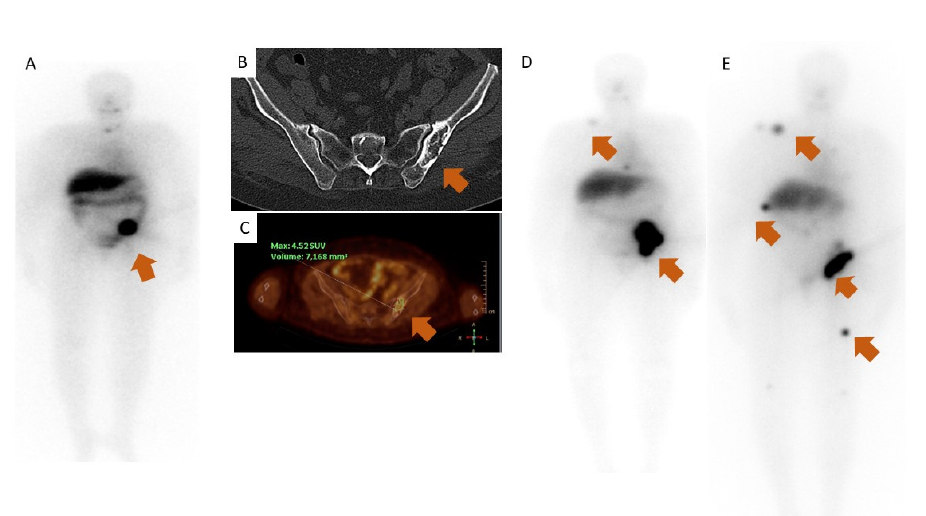
Figure 1. ( A ) Whole-body scintigraphy after 131 I treatment in 2012 showing tracer uptake (arrow) in the left iliac bone. ( B ) Computed tomography (CT) of pelvis, axial view (the arrow shows the metastasis). ( C ) 18F-fluorodeoxyglucose (18F-FDG)—positron emission tomography (PET) fused with CT. ( D ) Whole-body scintigraphy after the fourth 131 I treatment in 2018 showing an uptake in the left iliac bone and smaller areas of uptake in the right clavicle and thoracic spine (arrows). ( E ) Whole-body scintigraphy after the sixth 131 I treatment in 2020 showing an uptake in the left iliac bone and several other areas of smaller uptake (arrows). A 71-year-old woman presented in 2012 with a growing palpable mass in the right side of the neck. She had a past history of a toxic thyroid nodule for which she had been submitted to two treatments with radioactive iodine ( 131 I) (total activity of 19 mCi) in 1991. The neck ultrasound revealed an isoechoic solid thyroid nodule with 51 mm, and the fine needle aspiration diagnosed a benign nodule. She underwent right lobectomy followed by total thyroidectomy since histology revealed an oncocytic variant of follicular thyroid carcinoma with extensive vascular invasion. A few weeks later, she was